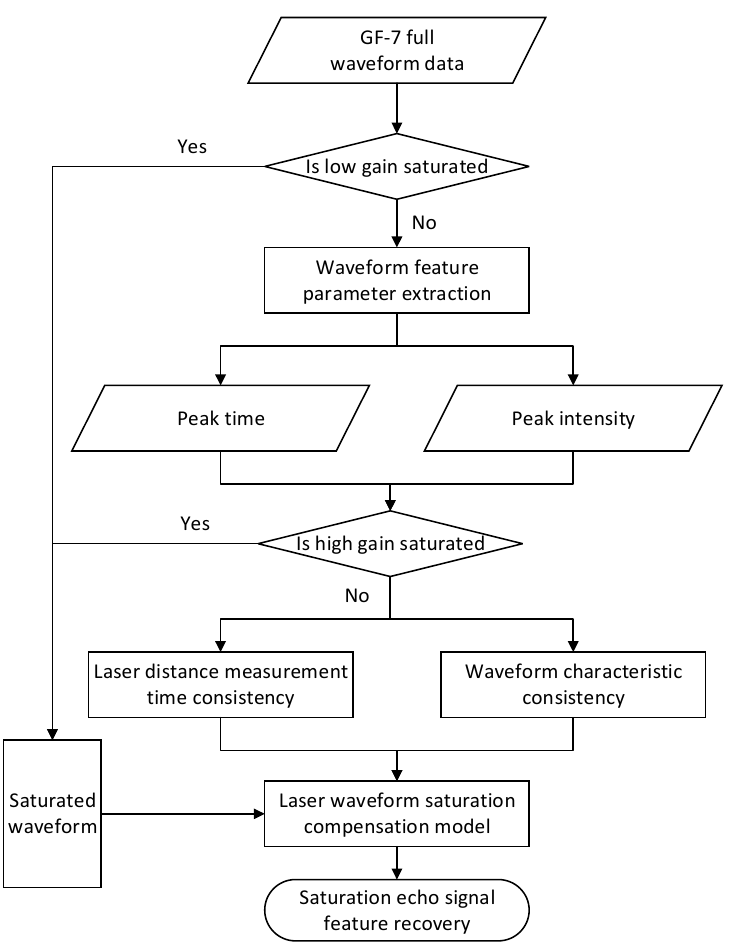
Figure 2. Flow chart of the laser waveform signal saturation compensation algorithm.